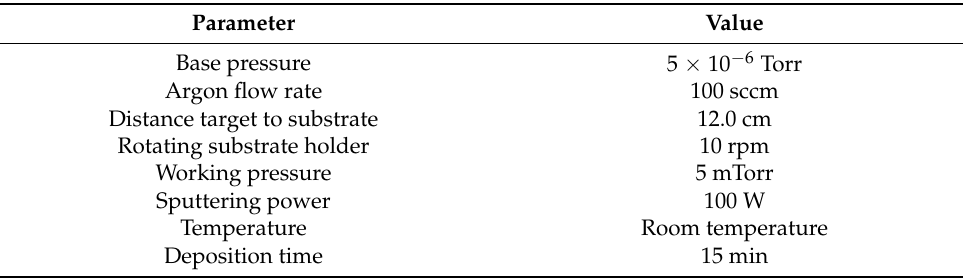
Table 1. List of parameters for the Al electrical